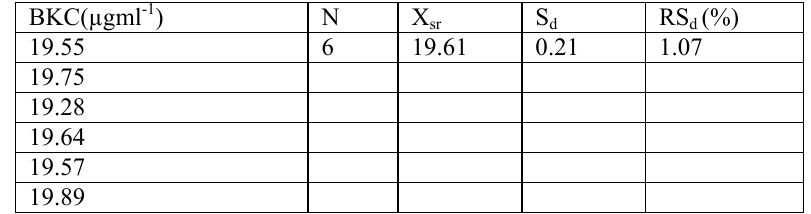
Table 2: Precision of the method.